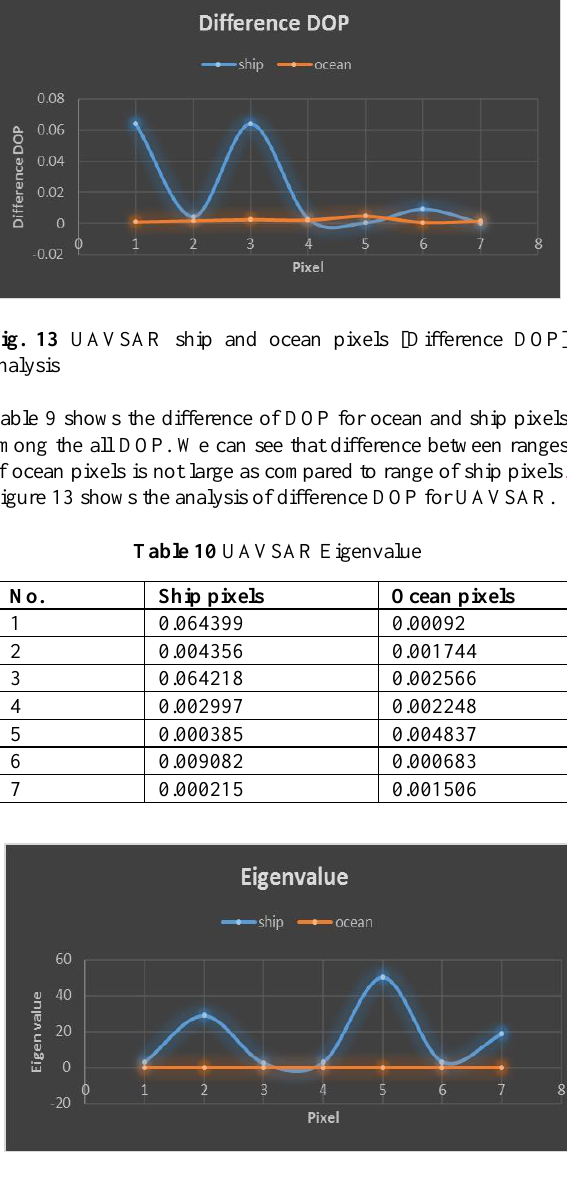
Fig. 14 UAVSAR ship and ocean pixels [Eigenvalue]